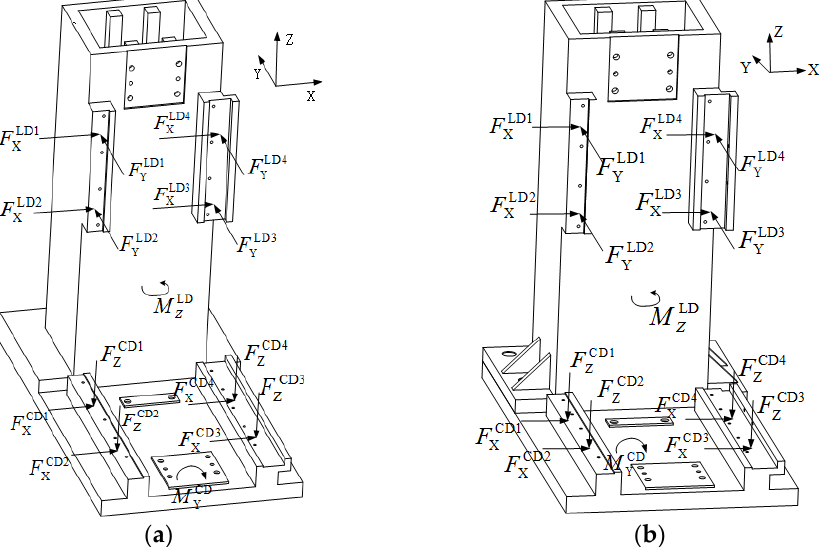
Figure 10. Equivalent load distribution on the connecting surface of the guide rail pair. ( a ) Integral structure ( b ) Separate structure.